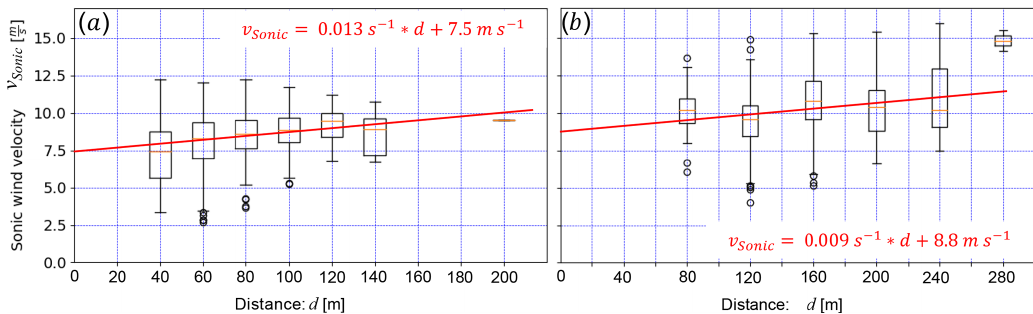
Figure 9. Sonic wind velocity as a function of the transport distance of the blowing snow events for (a) EP1and (b) EP2.